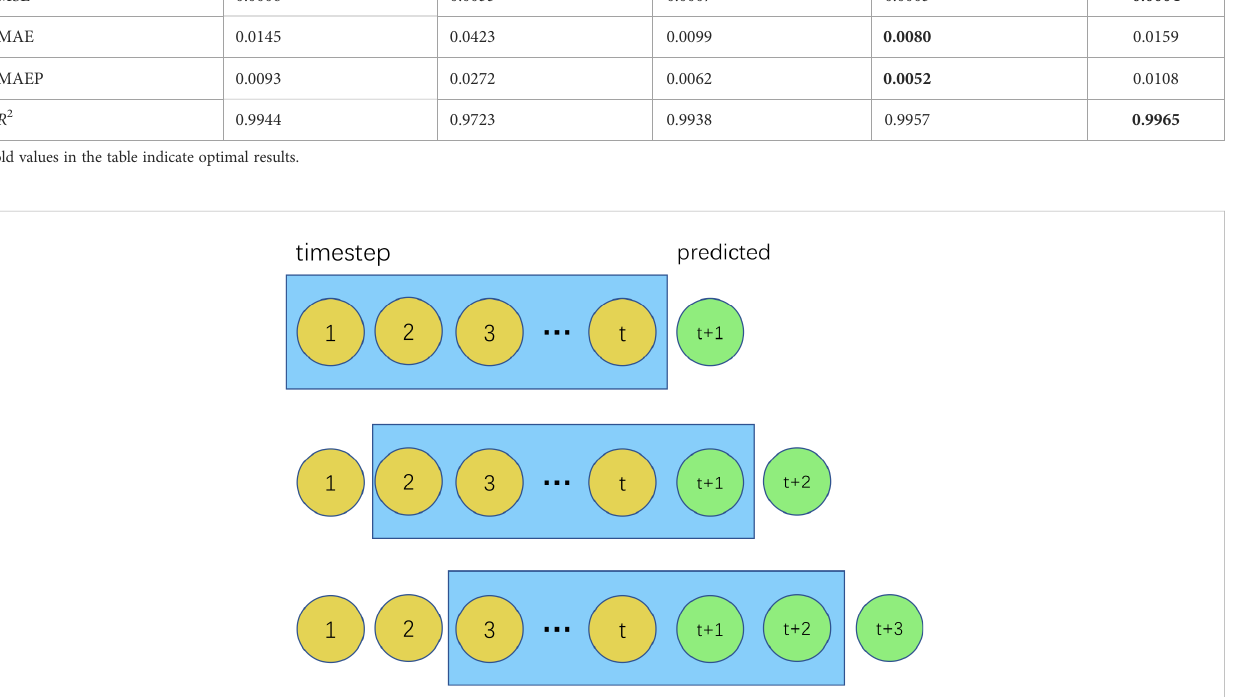
FIGURE 10 Principles of SWH prediction for multiple hours